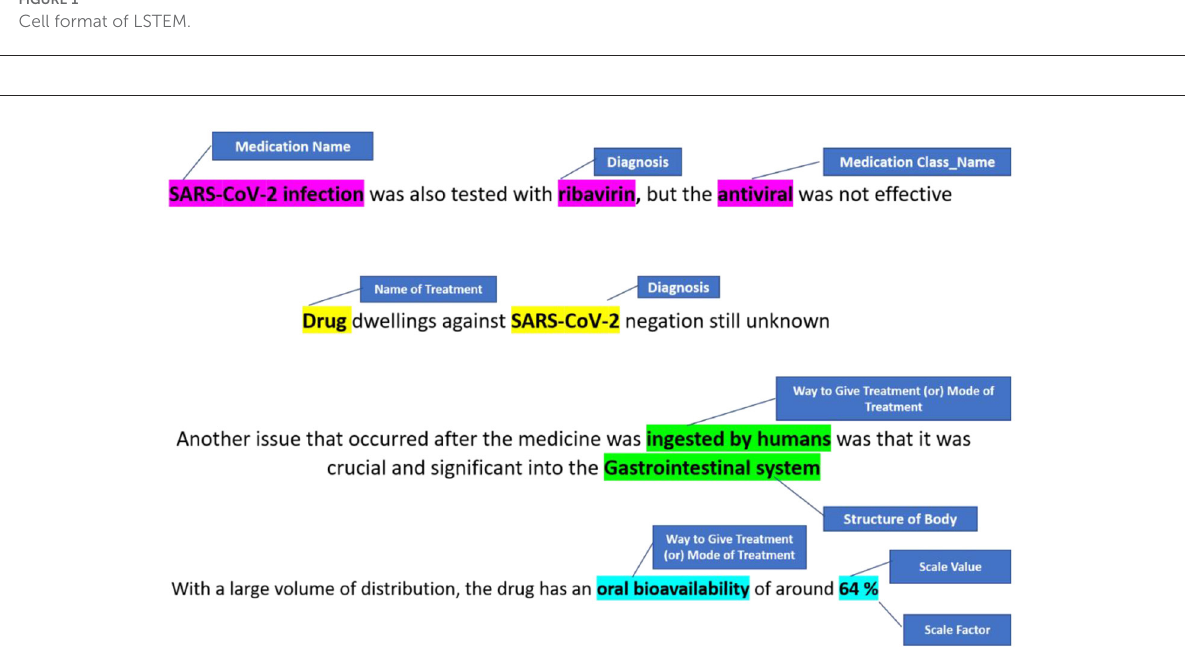
FIGURE2 Example of NER for clinical symptom